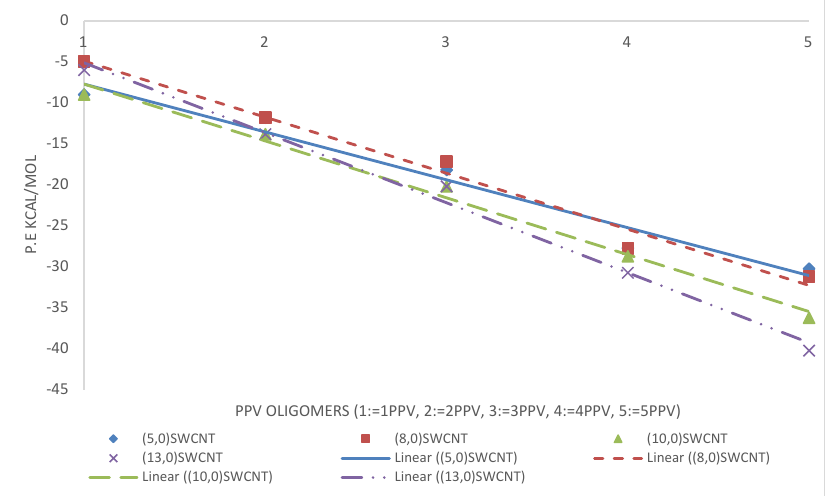
Figure 21. Binding energy of PPV oligomers with respect to (w.r.t) semiconductor SWCNTs.